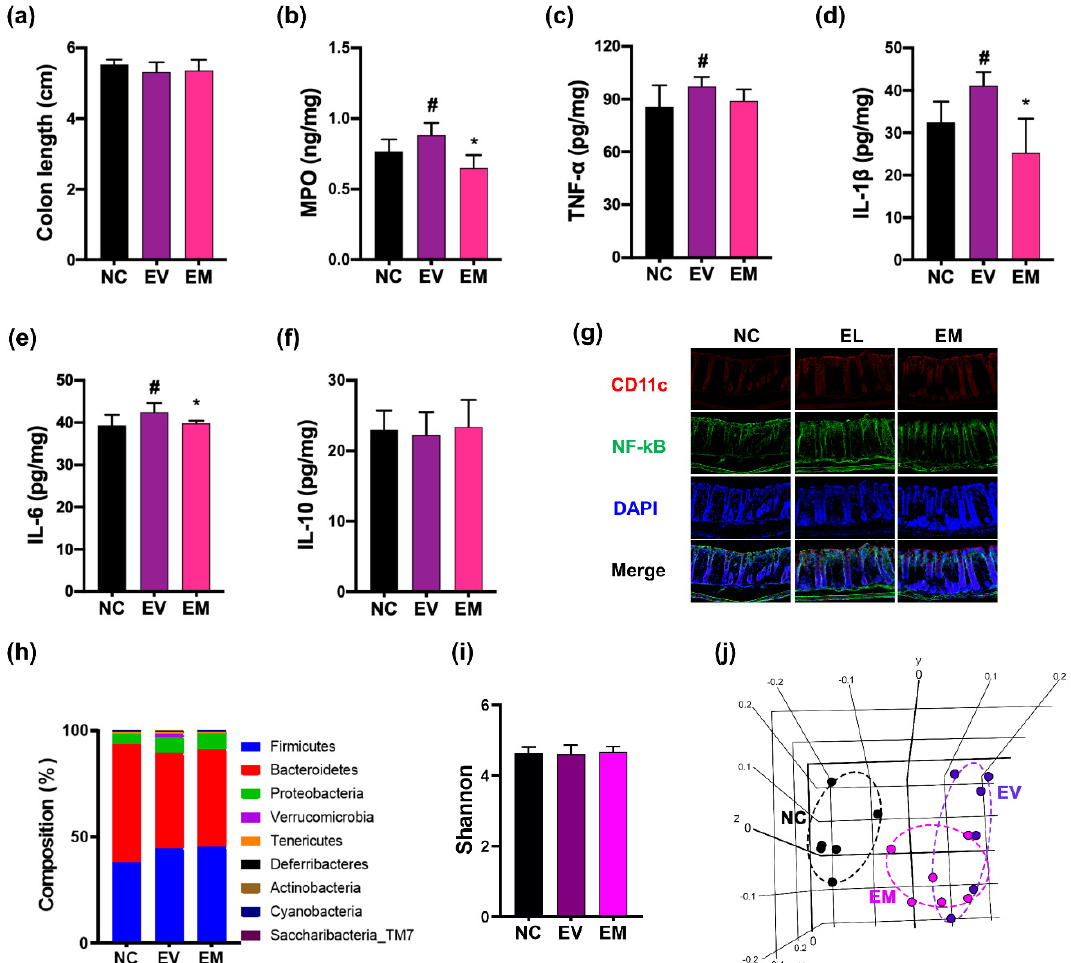
Figure 7. NKc alleviated pEVs-induced colitis and gut microbiota dysbiosis in mice. Effect on colon length ( a ), expression of MPO ( b ), TNF- α ( c ), IL-1 β ( d ), IL-6 ( e ), and IL-10 ( f ), and population of NF- κ B + CD11c + cells ( g ). Effect on gut bacterial composition: ( h ) phylum, ( i ) Shannon index ( α -diversity), and ( j ) β -diversity (based on UniFrac). Data were described as mean ± SD ( n = 6). # p < 0.05 vs. NC. * p < 0.05 vs. EV.